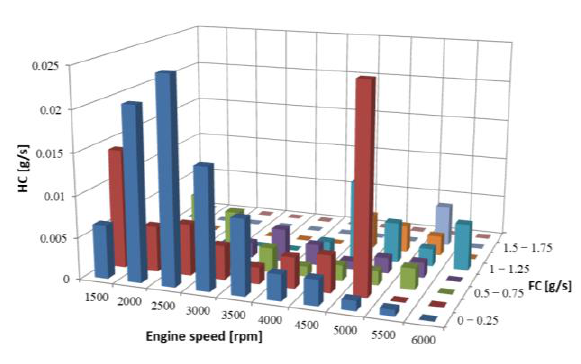
Fig. 10. HC emission per second as a function of engine speed and fuel consumption